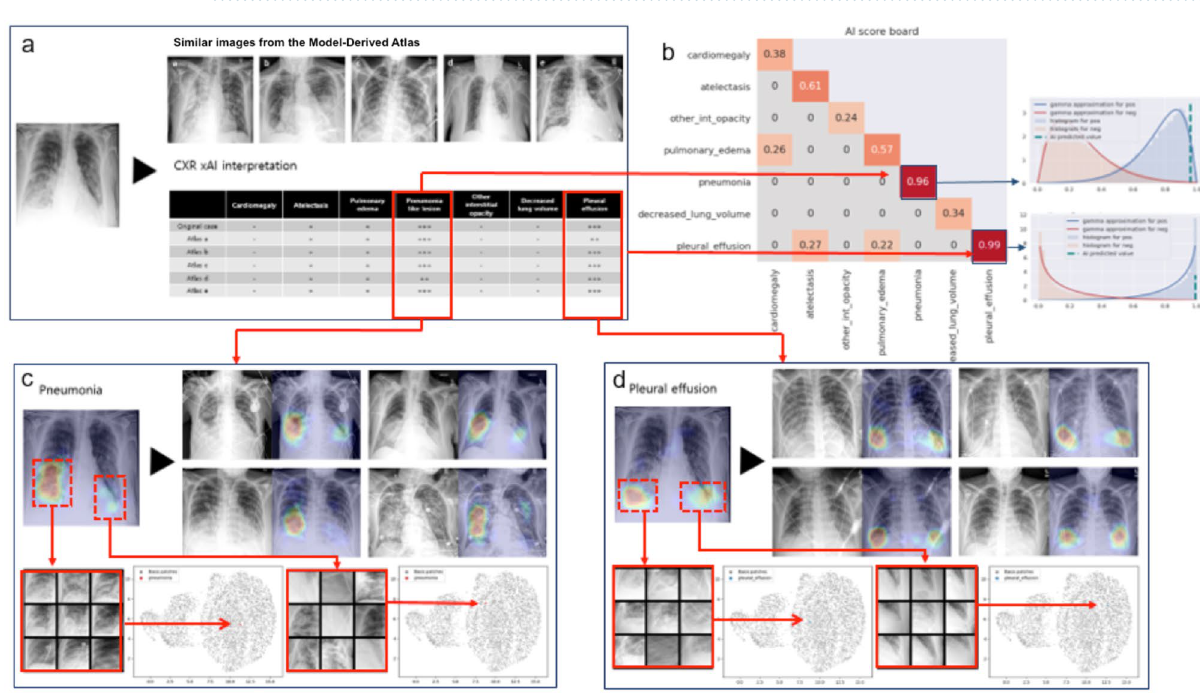
Figure 5. CXR interpretation by our xAI model for a patient who presented with respiratory infection. ( a ) The interpretation table shows 5 comparable CXRs selected from the Model-Derived Atlas and prediction probabilities for labels associated with respiratory infection. ( b ) Prediction probability was ≥ 0.90 on the AI scoreboard for pneumonia and pleural effusion. ( c,d ) Pneumonia and pleural effusion were correctly localized by Grad-CAM, and similar CXRs and patches were selected from the Model-Derived Atlas. UMAPs show that the test patches were close to corresponding patches from the Model-Derived Atlas, which supports that the testing patches can be classified as “pneumonia” and “pleural effusion”,